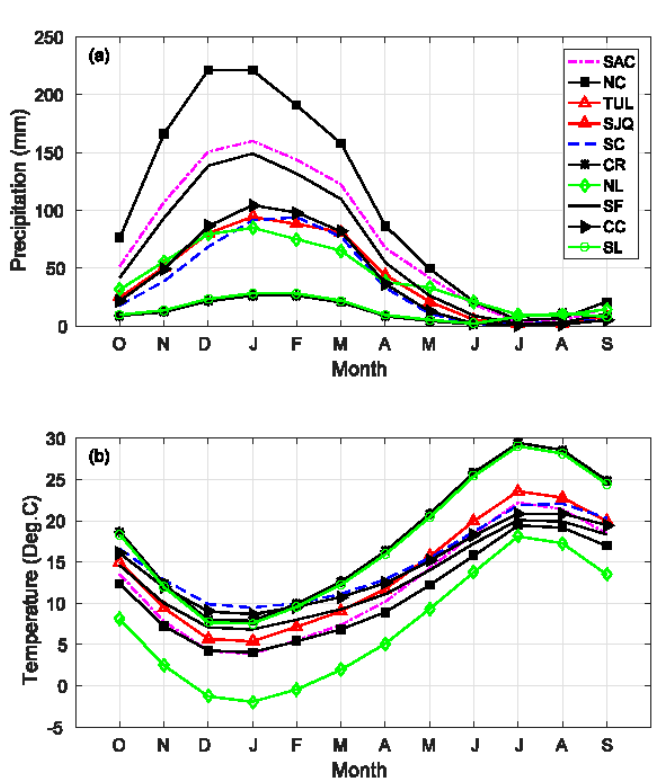
Figure A1. ( a ) Mean monthly precipitation; and ( b ) mean monthly average temperature of the hydrologic regions for October (O), November (N), December (D), January (J), February (F), March (M), April (A), May (M), June (J), July (J), August (A), and September (S).